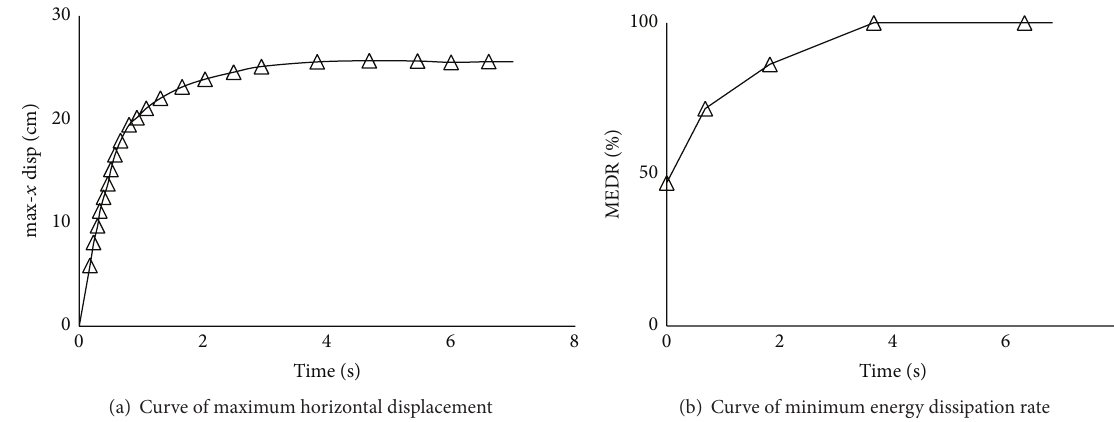
Figure 3: Results when strength reduction factor is 1.3.